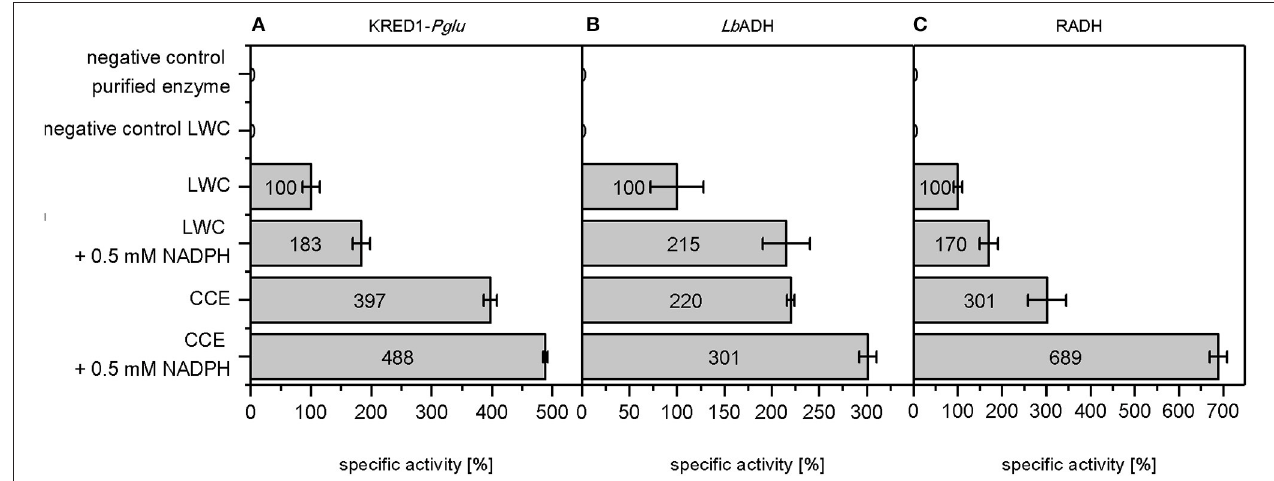
FIGURE 3 | Relative initial activities gained by whole cell regeneration from citrate. The capability of citrate to regenerate NADPH in a targeted oxidoreductase reaction was investigated with (A) Ogataea glucozyma CBS 5766 ketoreductase1 (KRED1 -Pglu ), (B) Lactobacillus brevis alcohol dehydrogenase ( Lb ADH), and (C) Ralstonia sp. alcohol dehydrogenase (RADH) as lyophilized whole cell (LWC) and crude cell extract catalysts. The “negative control purified enzyme” contained the oxidoreductases in purified form instead of LWC/CCE. The “negative control LWC”: contained all compounds except citrate. The reaction setups with “0.5mM NADPH” contained NADPH instead of citrate. 0.10U mg − 1 KRED1- Pglu LWC, 1.61U mg − 1 Lb ADH LWC, and 0.81U mg − 1 RADH LWC were normalized to 100% specific activity. n =